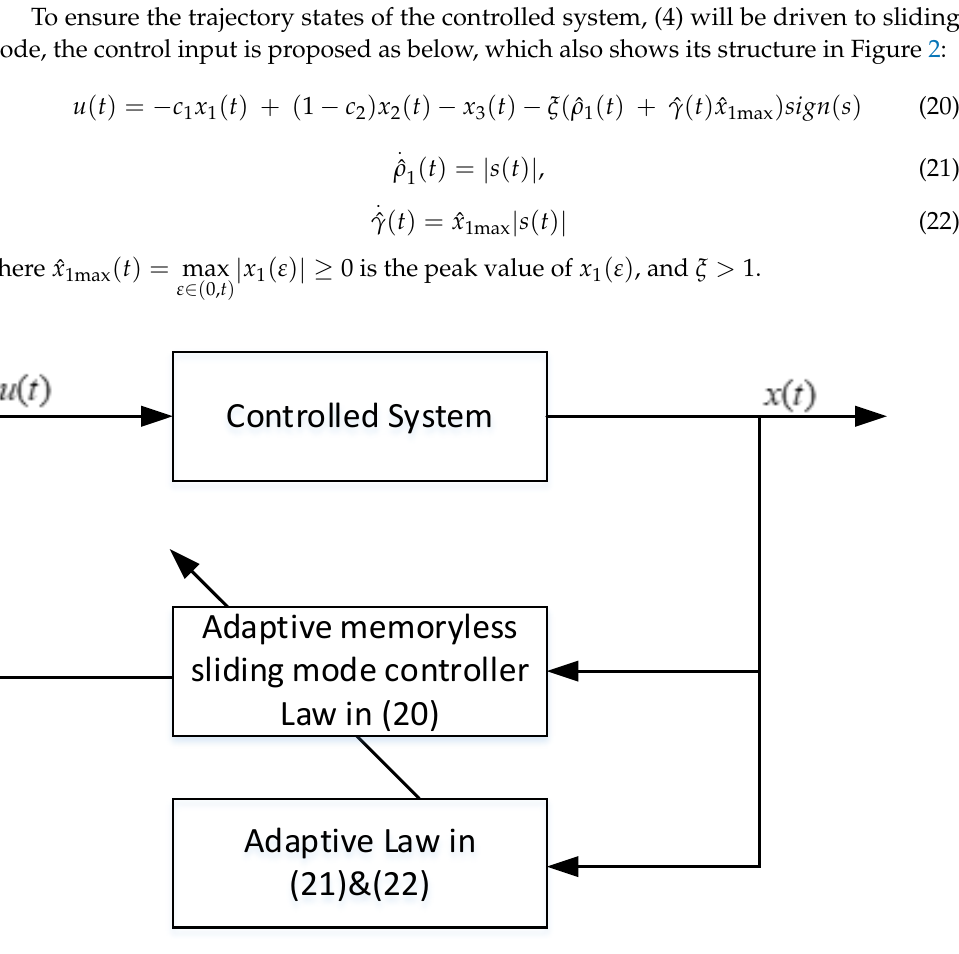
Figure 2. The structure of the proposed adaptive memoryless sliding mode controller. Theorem 1. Considering uncertain Rössler systems with unknown time delays and external disturbances as described in (4), the trajectories of the controlled system should converge to the sliding manifolds ( t ) = 0 , asymptotically with the control input (20) and adaptive laws (21) and